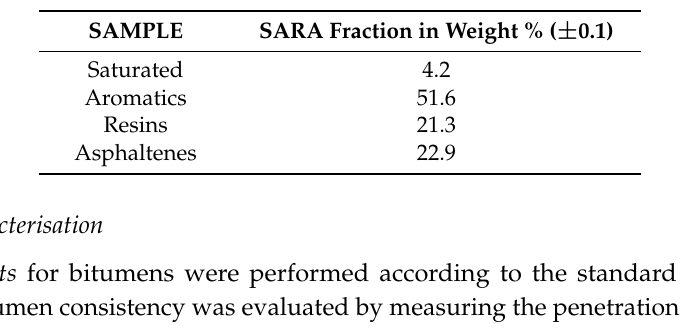
Table 1. Group composition of the tested neat